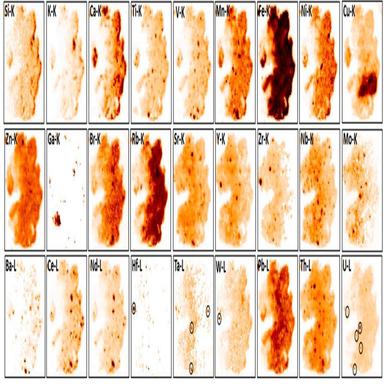
Elemental μ-XRF maps of a soil particle from the Fen site. For the low-concentration elements Hf, Ta, W and U, their presence is highlighted by black circles around the hotspots where they prevalently occur in their distribution images. Map size: 1950 � 1950 μm2 , step size 30 μm, 7 s/pixel.